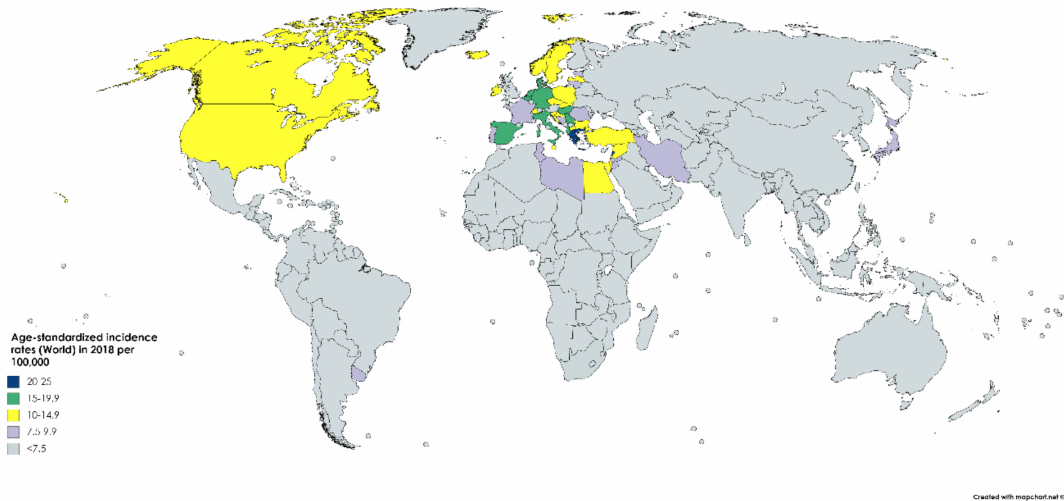
Figure 2. Map showing estimated age-standardized incidence rates (ASR) for bladder cancer worldwide in 2018, all sexes, including all ages. Created with mapchart.net. Data obtained from Globocan 2018